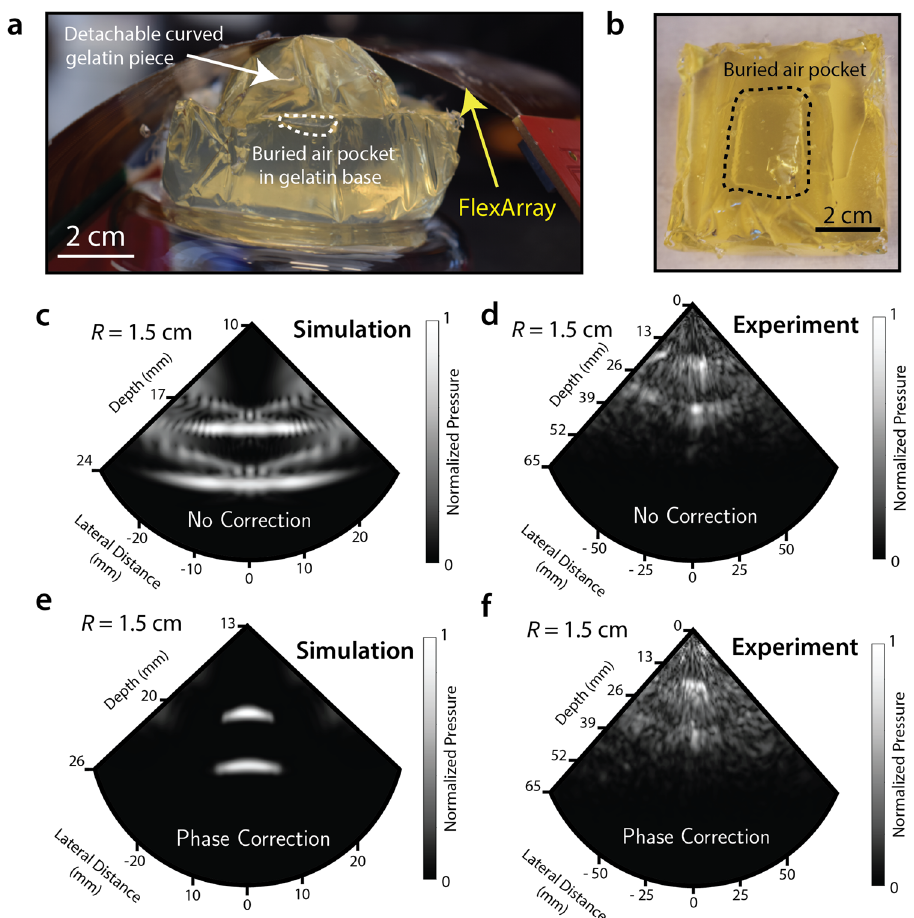
Figure 5. Effects of phase correction on image formation tested on gelatin phantoms of arbitrary curvature. ( a ) Photograph of the cast gelatin phantom used to collect B-mode images at arbitrary curvatures. The FlexArray is seen conforming to the surface. ( b ) Plan-view photograph of the air pocket-containing gelatin mould. ( c ) Simulated B-mode image when the radius of curvature is 1.5 cm and phase correction is not implemented. ( d ) Experimental B-mode image of an air pocket in gelatin captured with the FlexArray when the radius of curvature is 1.5 cm; without phase correction. ( e ) Simulated B-mode image when the radius of curvature is 1.5 cm and phase correction is implemented. ( f ) Experimental B-mode image of an air pocket in gelatin captured with the FlexArray when the radius of curvature is 1.5 cm; with implemented phase correction. Both images in ( d ) and ( f ) are compound averaged focal series images between f = 2, 3 and 4